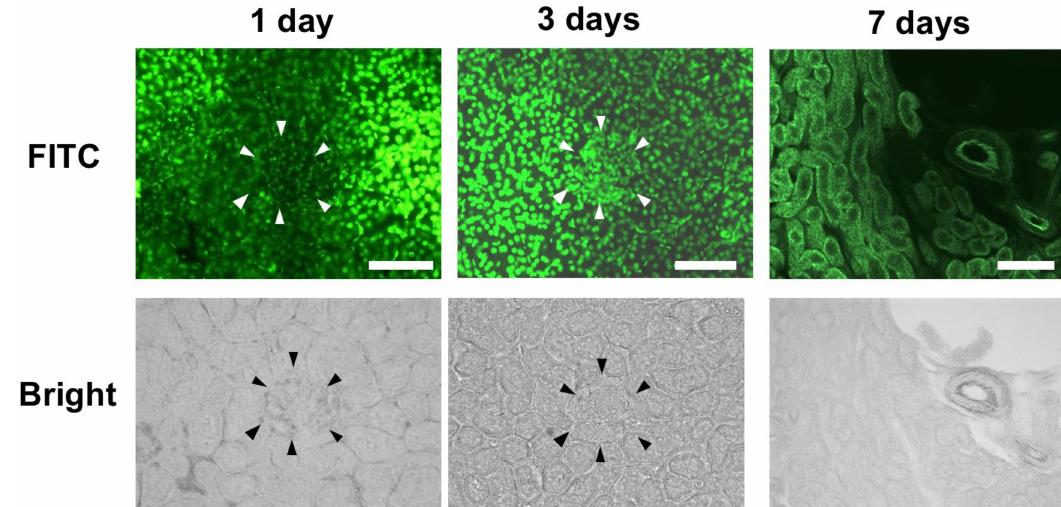
Figure 4. Delivery of pyrrole-imidazole (PI) polyamide targeting TGF- β 1 in rat kidney. One milligram of FITC-PI polyamide was injected intraperitoneally into Wistar rats. After 1, 3, and 7 days, the kidneys were removed, and frozen specimens were prepared and viewed. Scale bar indicates 25 µ m. The arrow heads distinguish the glomerulus from nephrotubules.